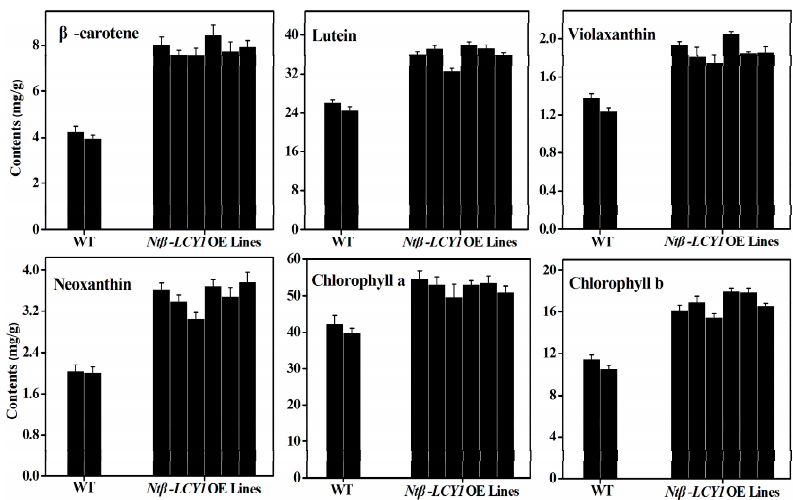
transgenic lines used as the PCR template. Error bars represent standard deviation ( n = 3). The data presented here are representative of three independent experiments.